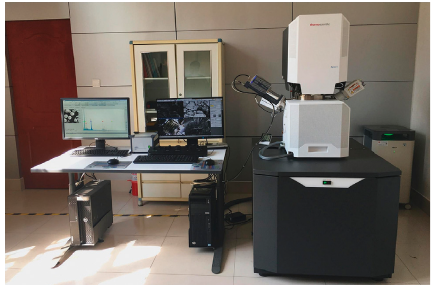
Figure 3: Apreo high-resolution Table 6: Setting time and compressive strengths of samples at different ages.